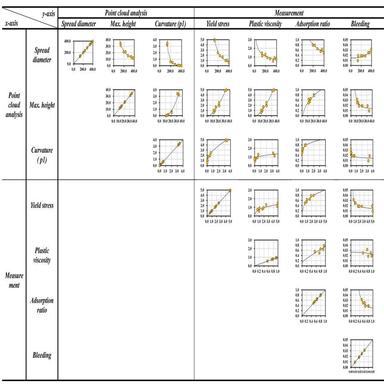
Correlation of point cloud-based data, rheological properties, superplasticizer adsorption, and bleeding.